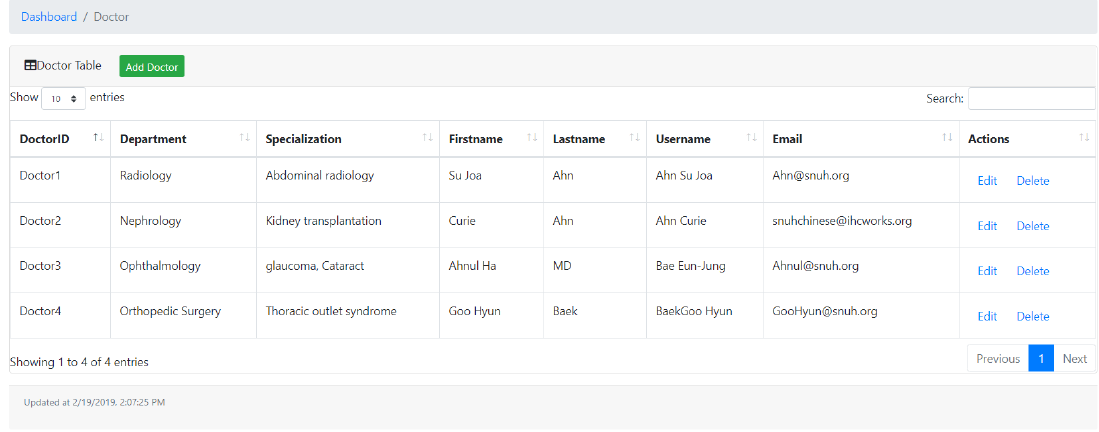
Figure 15. Doctor management dashboard.